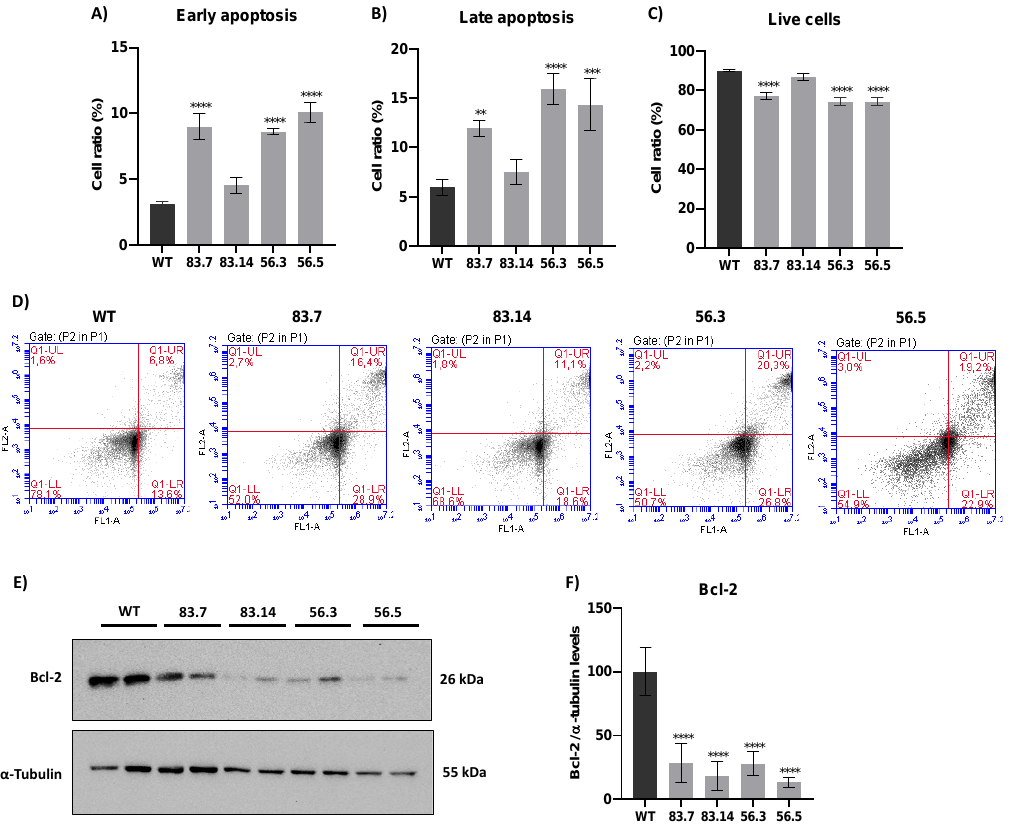
Figure 5. NEK6-KO induces cell death. ( A ) WT and NEK6-KO cells were stained with annexin V and propidium iodide to assess cell death by flow cytometry. NEK6 knockout cells (83.7, 56.3, and 56.5) showed a significant induction of early and ( B ) late cell death, ( C ) with the consequent reduction of live cells. ( D ) Representation of plots obtained by the flow cytometry analysis. ( E ) Bcl-2 expression was analyzed in NEK6-KO cell lines by Western blotting. ( F ) Statistical analysis of Bcl-2 expression. Bcl-2 expression was drastically reduced in NEK6-KO cells. ** p < 0.01, *** p < 0.001, and **** p <